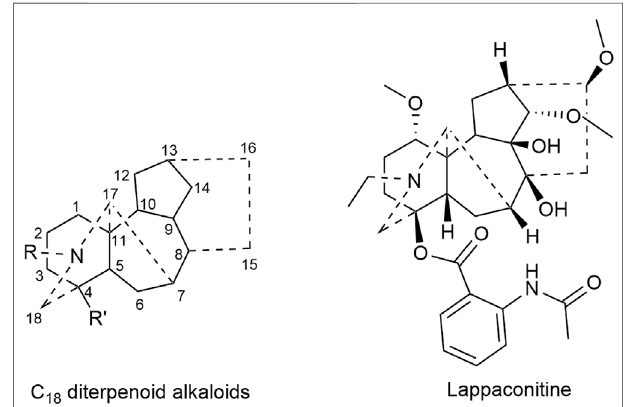
FIGURE 1 | Structures of lappaconitine and C 18 diterpenoid alkaloids in Fuzi.